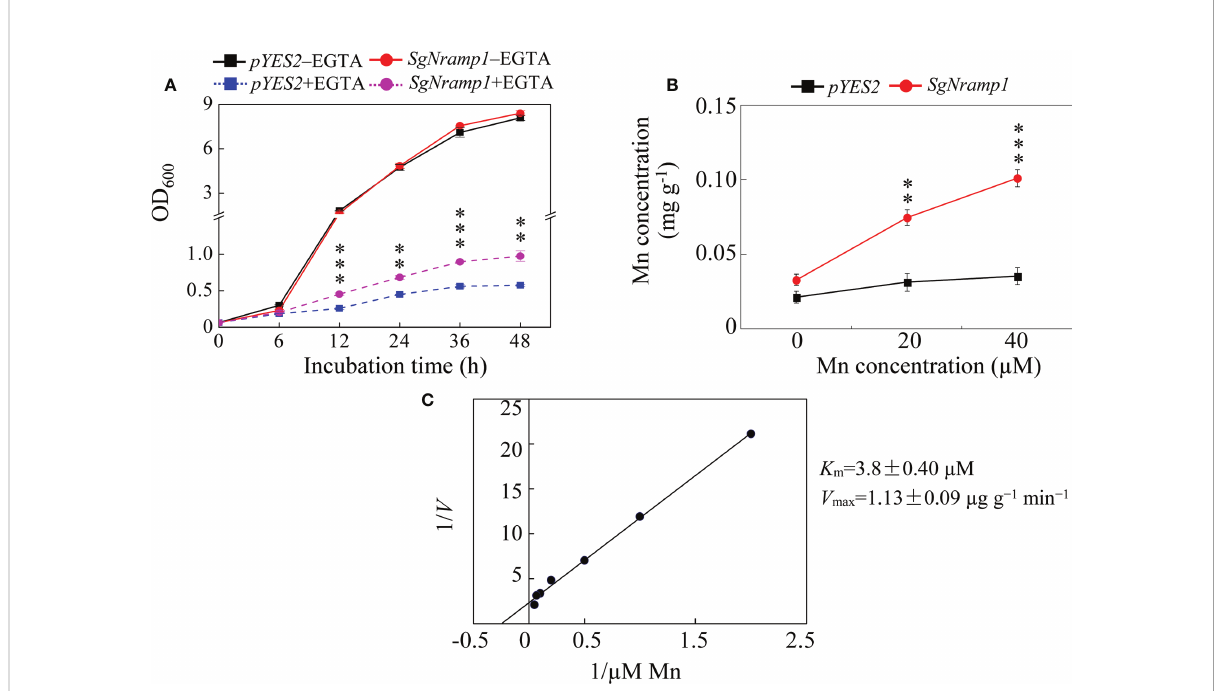
FIGURE 8 Growth and Mn uptake in yeast mutant D smf1 expressing SgNramp1 . (A) The yeast mutant D smf1 expressing either the pYES2 empty vector or SgNramp1 was grown in SC-U/Gal liquid medium with or without 20 mM EGTA for 0h to 48h. (B) Mn concentrations in the yeast cells grown in SC-U/Gal liquid medium containing 0, 20, or 40 m М MnSO 4 for 24h. (C) The kinetics of Mn uptake in yeast cells. The kinetics parameters are shown next to the fi gure. Data are means of three biological replicates with SE. Asterisks indicate signi fi cant differences between the pYES2 empty vector and SgNramp1 . **0.001 < P < 0.01; *** P <